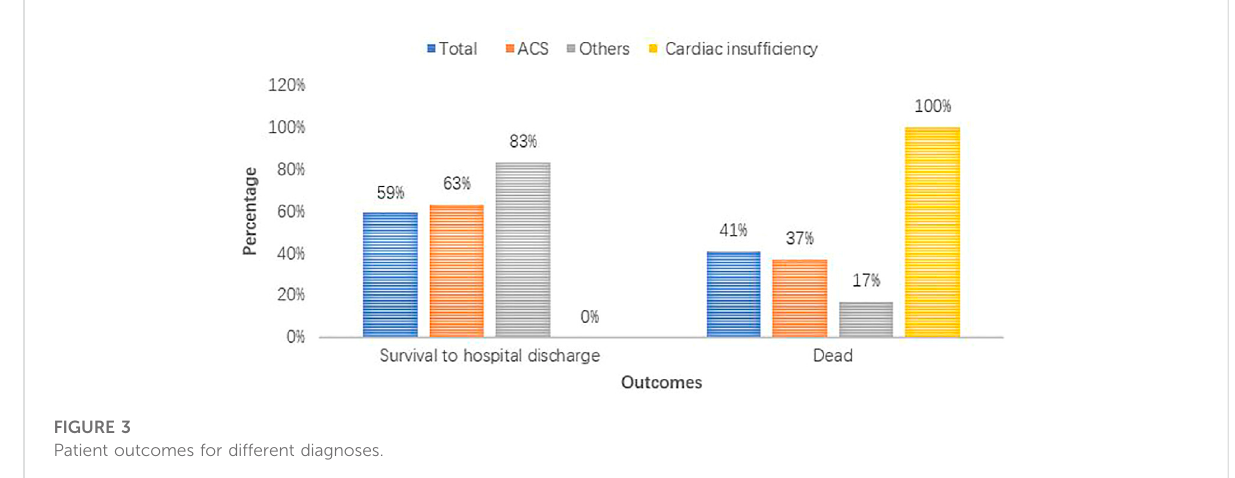
FIGURE 3 Patient outcomes for different diagnoses.